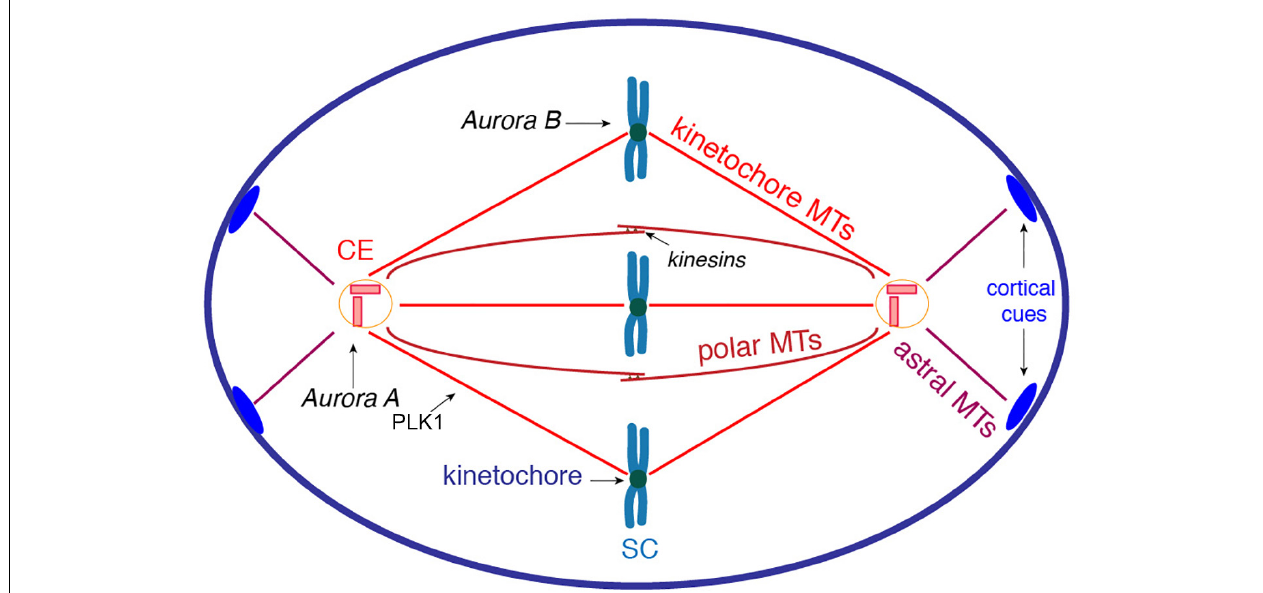
FIGURE 1 | Schematic representation of spindle organization during mitosis. The centrosomes organize three types of MT fibers that are polymerized from the γ -TuRC associated to the PCM. The kinetochore MTs are directed toward the kinetochores to generate the traction forces required to separate the sister chromatids. The polar MTs form antiparallel spindle fibers; kinesin motors at the spindle midzone exert sliding forces to induce both separation and elongation of the spindle poles. The astral MTs are pulled toward specific cortical cues (blue ovals) to generate rotation forces required to reach proper spindle orientation. Key kinases involved in spindle formation: Aurora A associates with centrosomes and regulates centrosome maturation, mitotic entry and spindle elongation; Aurora B orchestrates chromosome-MT attachment and sister chromatid cohesion; and PLK1 regulates MT dynamics during spindle formation. CE, centrosome; SC, sister